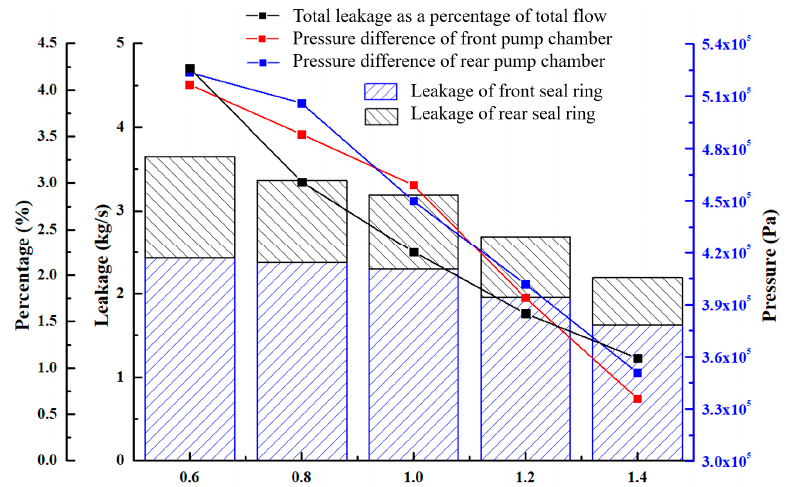
Figure 11. Leakage and pump chamber pressure di ff erence Leakage and pump chamber pressure difference statistics.